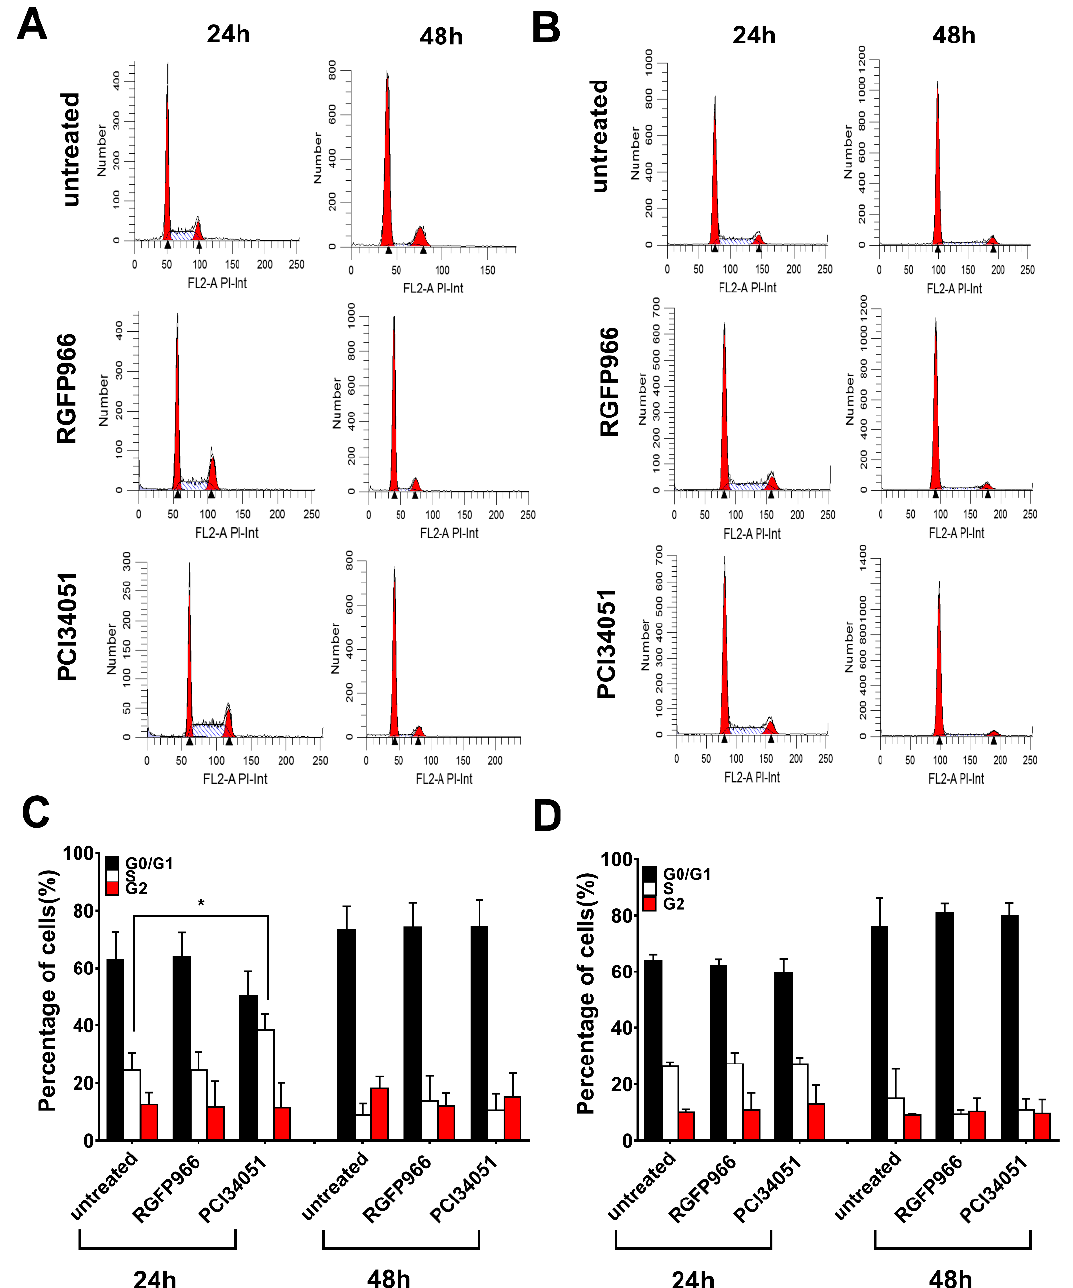
Figure 6. PCI34051 arrest in the G0/G1 phase in DLD-1 cells after 24 h incubation. DLD-1 ( A , C ) or WiDr ( B , D ) cells were incubated with 5 μ M RGFP966 or PCI34051 for 24 h or 48 h and then cell cycles were measured after incubation. Statistical analysis in ( C ) or ( D ) are according to ( A ) or ( B ). The values shown are mean ± SD from one of three experiments performed in triplicate. p values were analyzed by one-way ANOVA in Turkey’s multiple comparison with Graphpad Prism version 7.0. * 0.01 ≤ p ≤ 0.05.